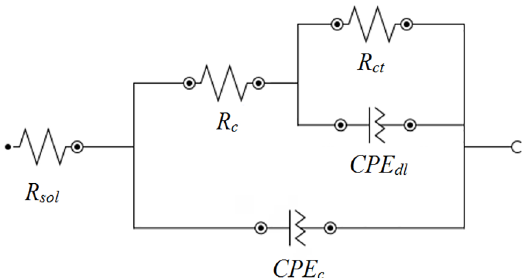
Figure 8. Equivalent circuit for Co-Ni/SiC coatings and base metal in a 3.5 wt.% NaCl